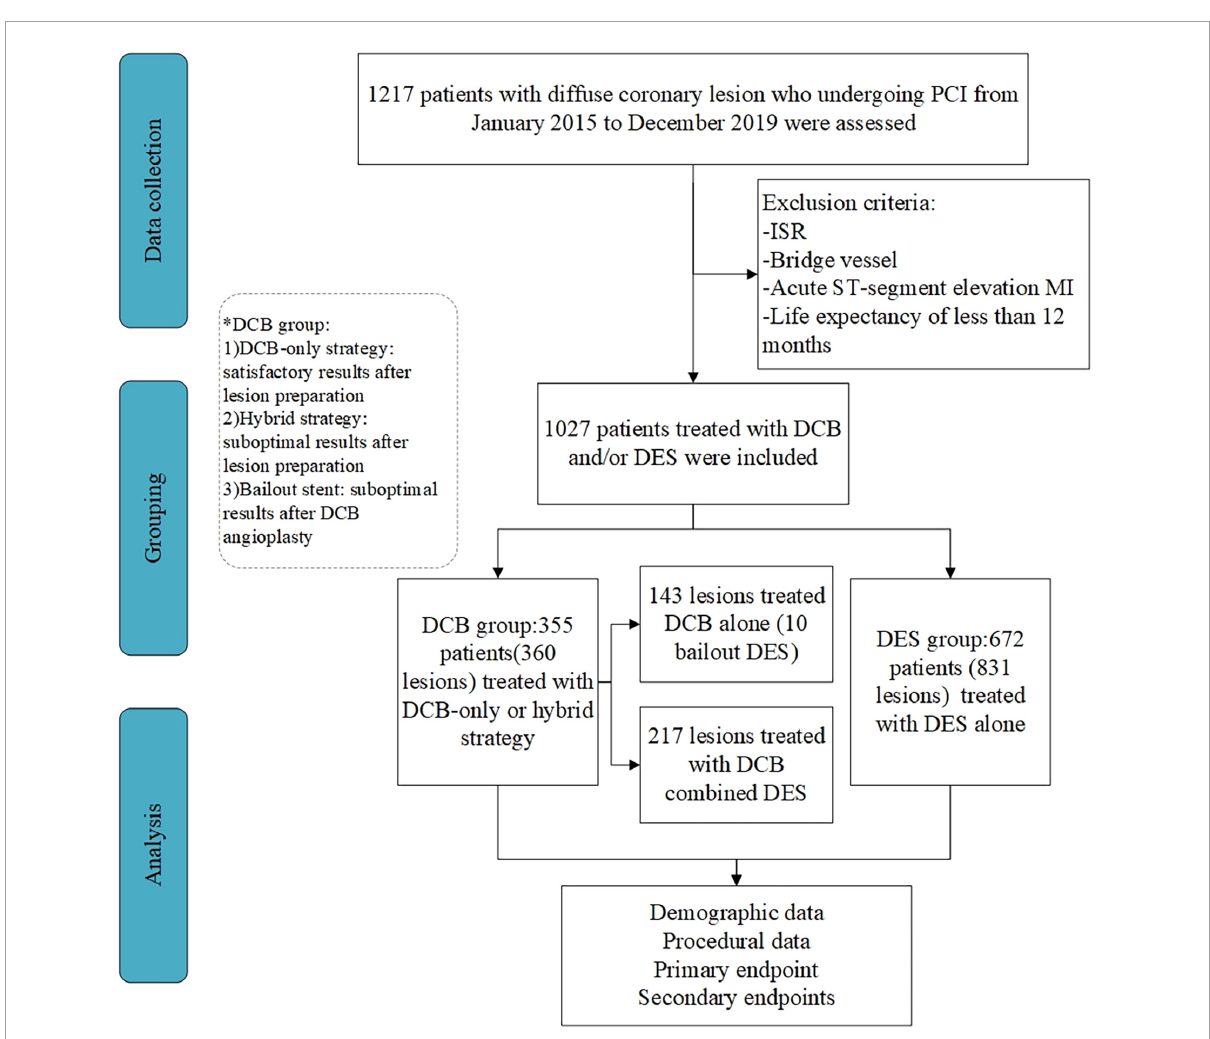
FIGURE1 Flow of patient inclusion in the study. PCI, percutaneous coronary intervention; ISR, in-stent restenosis; CABG, coronary artery bypass grafting; MI, myocardial infarction; DCB, drug-coated balloon; DES, drug-eluting